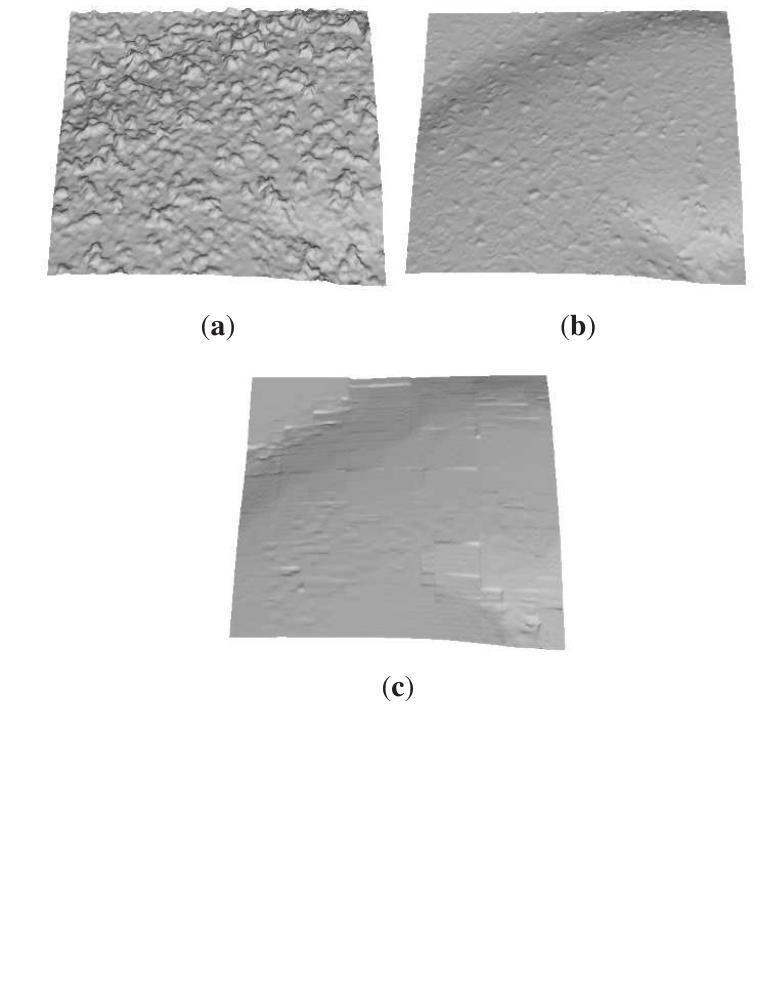
Figure 11. Comparing DTMs produced by (a) Karl Kraus (KK), (b) Peter Axelsson (PA) and (c) Maguya Almasi (MA) at Site 2. The width of the DTM section is approximately 400